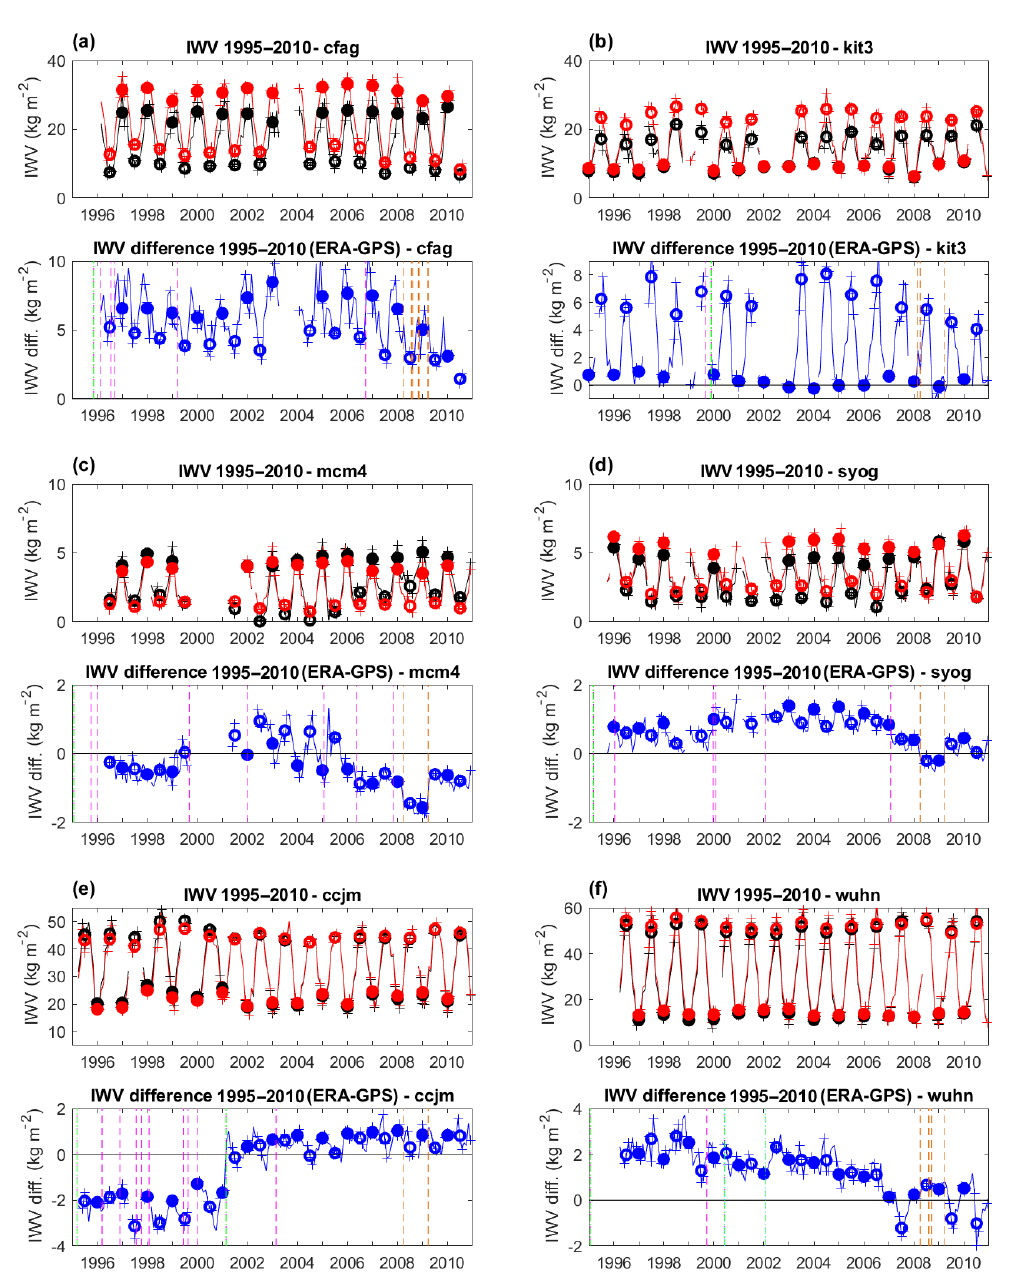
Figure B2. Time series of IWV from GPS (black) and ERAI (red), and IWV difference (blue) at stations (a) CFAG, (b) KIT3, (c) MCM4, (d) SYOG, (e) CCJM, and (f) WUHN. Filled circles show DJF values and open circles JJA values. Crosses show individual months used in both seasons. Vertical dashed lines indicate GPS equipment changes (receiver in magenta, antenna in green) and GPS processing changes (in orange). Note the change in vertical scales between